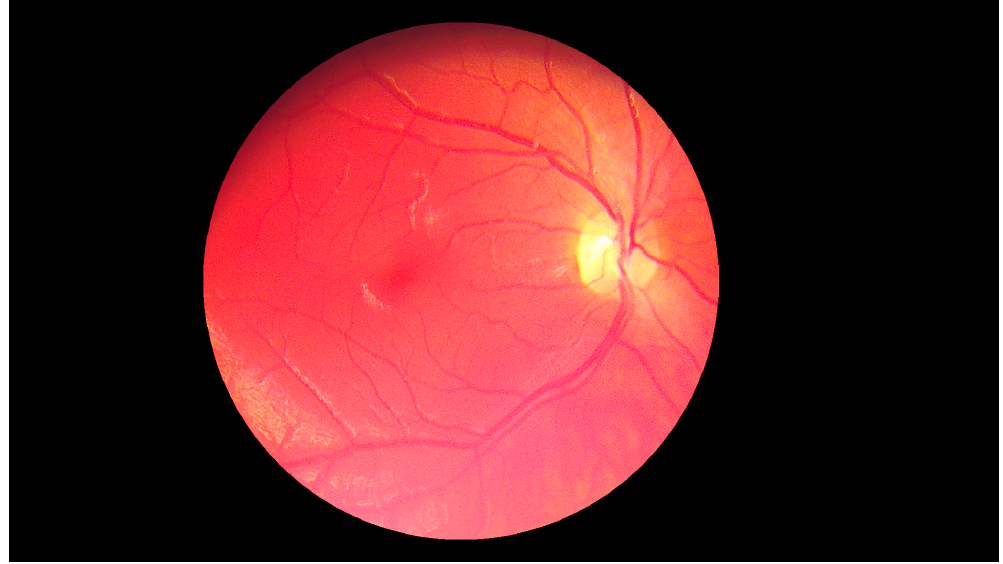
Figure 19. Retina color image obtained by the device with worse parameters. No pathological changes exist.